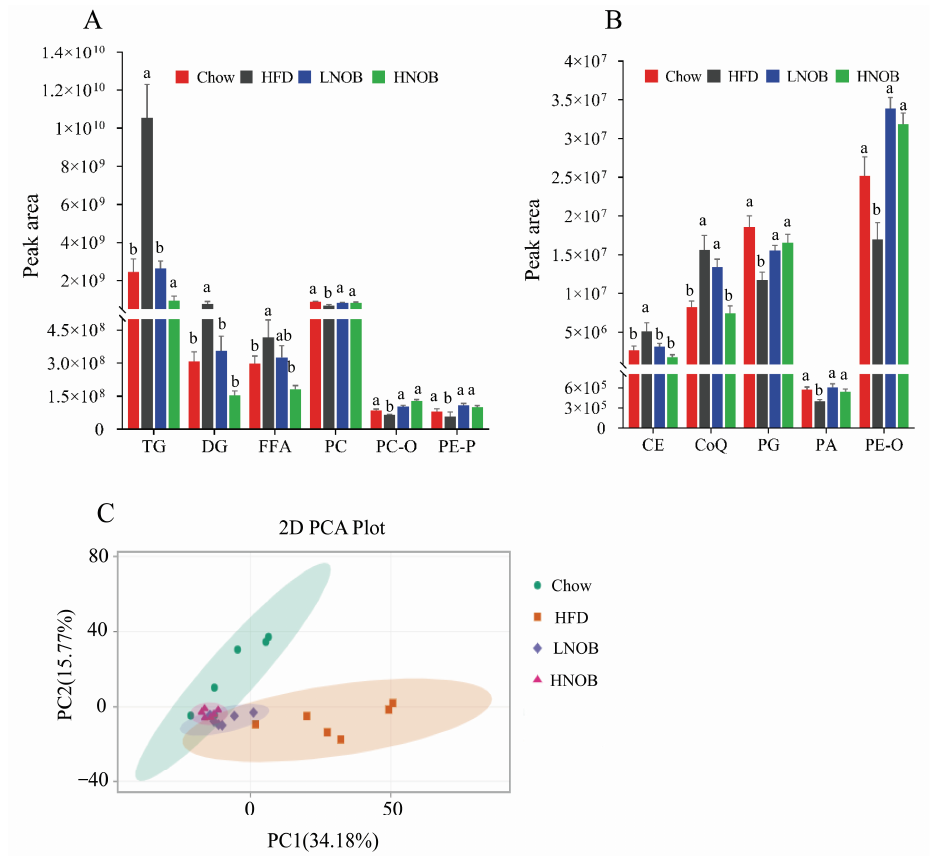
Figure 3. Lipidomic analysis of liver samples. The relative intensity of different lipid compositions in liver tissues ( A , B ). The PCA score plots of lipid profiling in liver tissues among four groups ( C ). Data are shown as mean ± SD ( n = 6). Data with different letters (a, b, c) represent significant difference ( p < 0.05), whereas bars with the same letter correspond to values that exhibit no significant differences. In the case where two letters are present on top of the bars in A, each letter should be compared separately with the letters of other bars to determine whether the values show significant